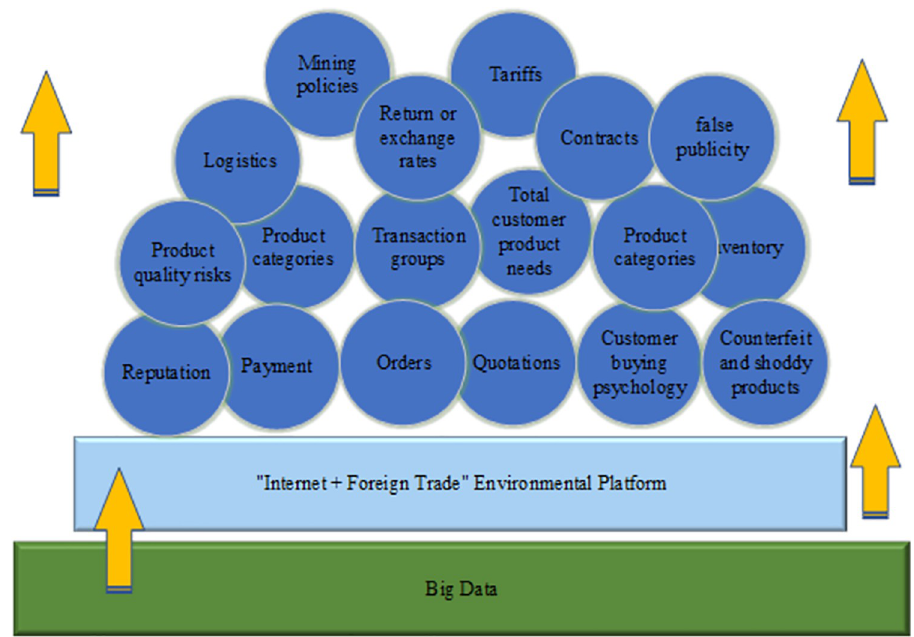
Fig 1. Big data mining content.